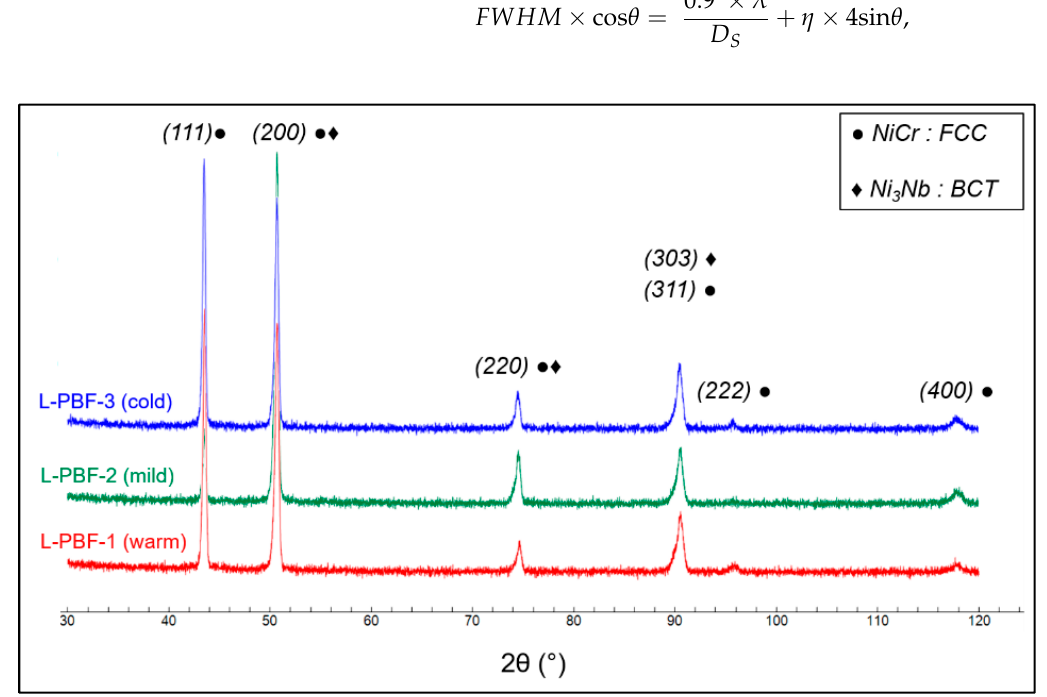
Figure 7. X-ray diffractograms of L-PBF samples.